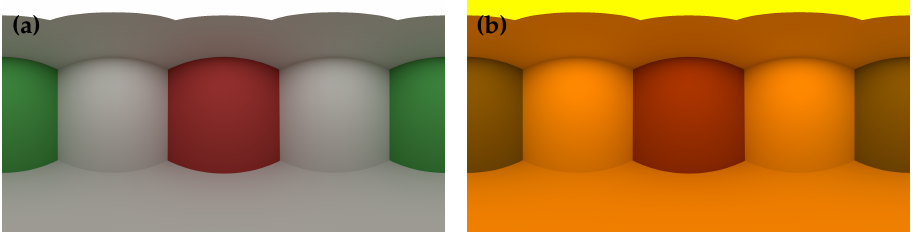
Figure 12. Environment maps for spectral IBL. ( a ) D65. ( b ) HP1.